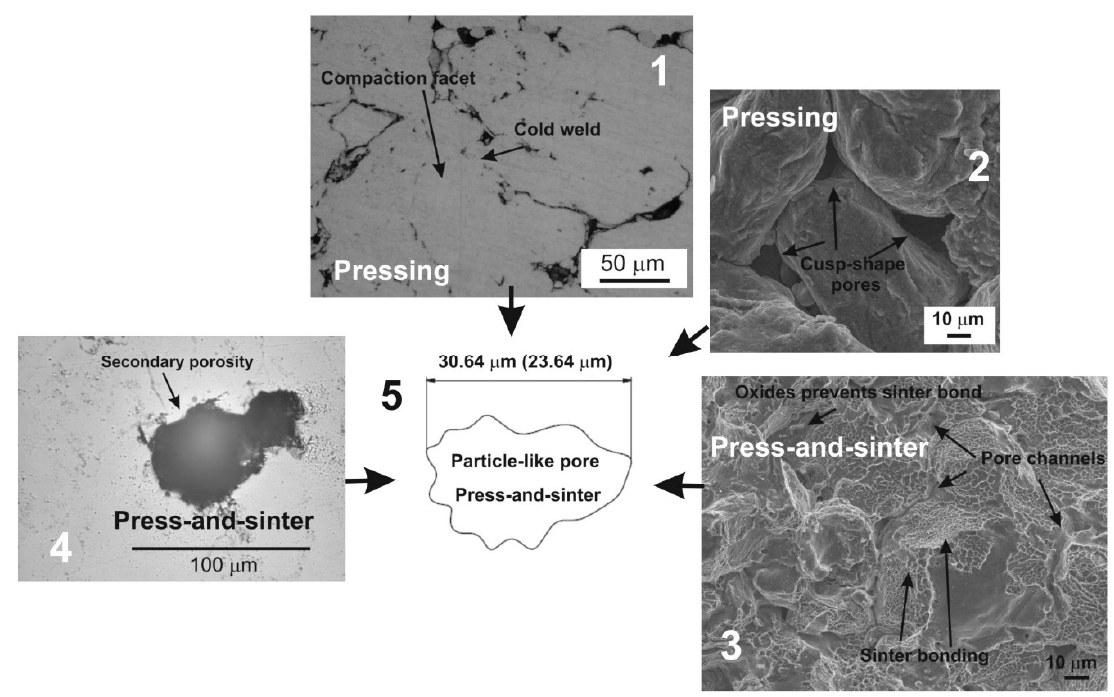
Figure 8. Overview of the press-and-sinter process in aluminum PM alloy.